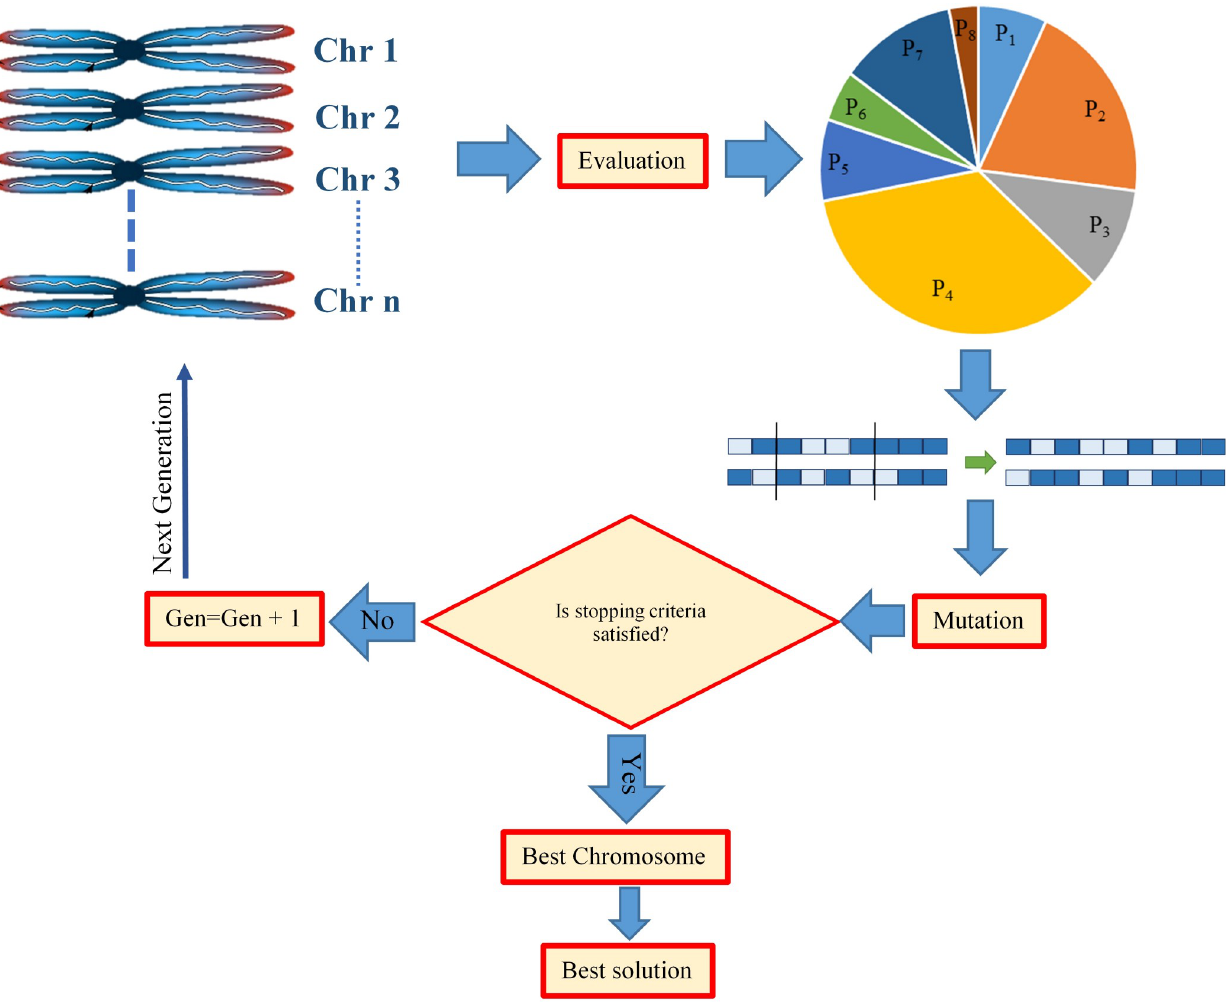
Fig 1. The schematic diagram of the genetic algorithm as the single objective evolutionary optimization algorithm.